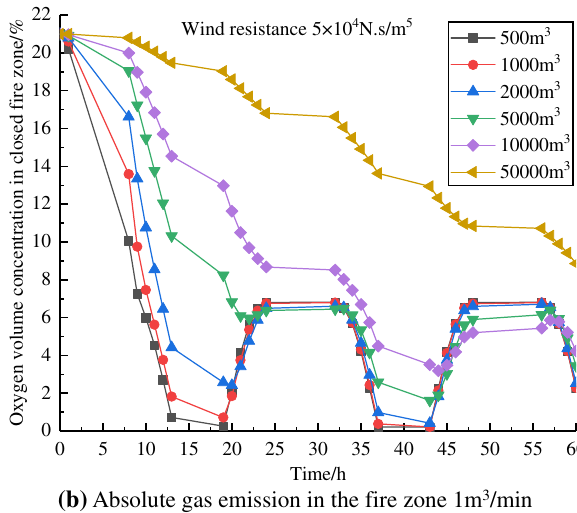
(a) Absolute gas emission in the fire zone 10m 3 /min